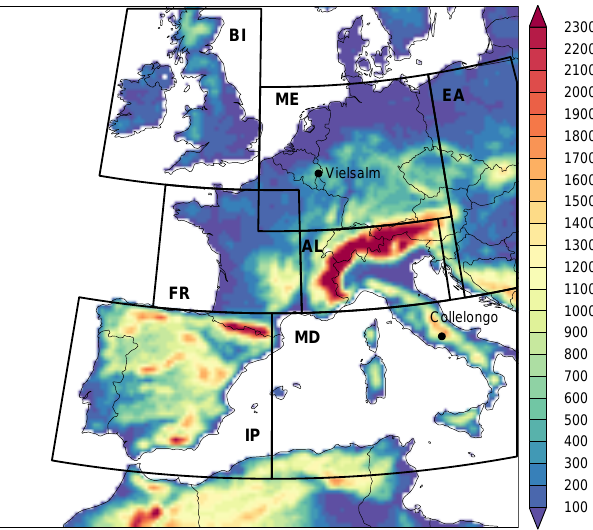
Figure 1. The total domain on 20km horizontal resolution and the subdomains (BI, IP, FR, ME, AL, MD, EA) based on the subdo- mains selected in the EURO-CORDEX framework. The colour rep- resents the orography (m) in the ALARO + SURFEX set-up. The two FLUXNET stations focused on in this study are Vielsalm (mar- itime temperate climate) and Collelongo (humid subtropical cli-